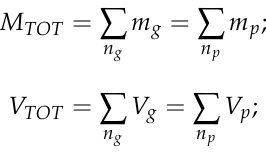
Table 1. Definitions of the coarse-graining parameters.